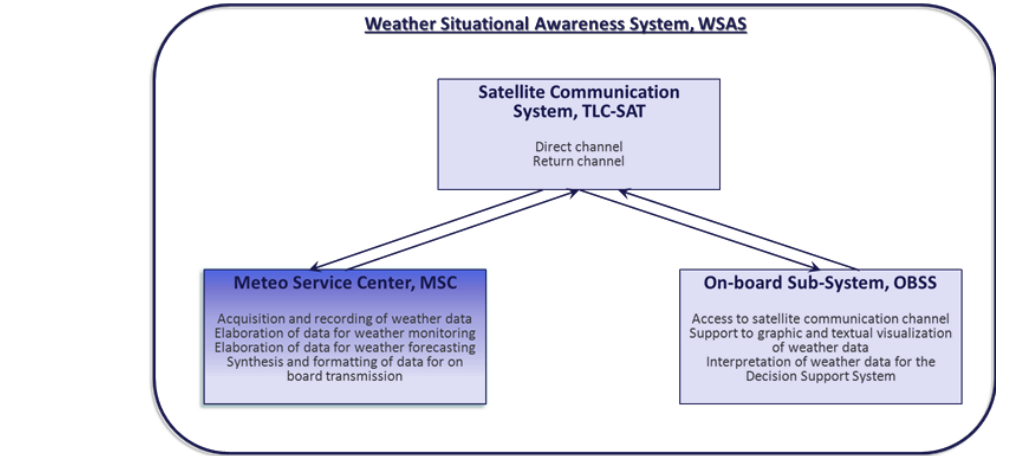
Figure 1. Weather Situational Awareness System block